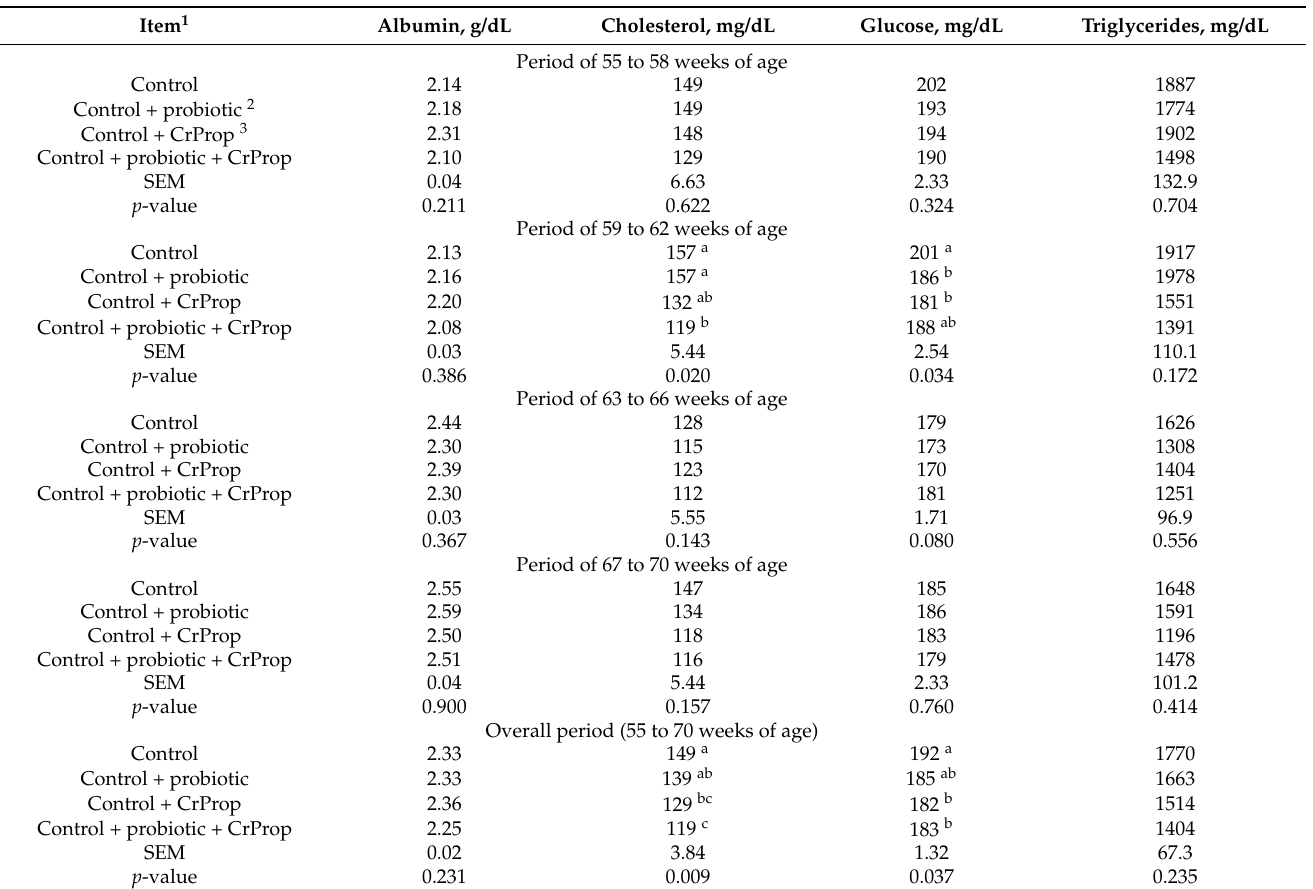
Table 4. Blood biochemical results of layer breeders fed diets supplemented with the probiotic and chromium propionate from 55 to 70 weeks of age.